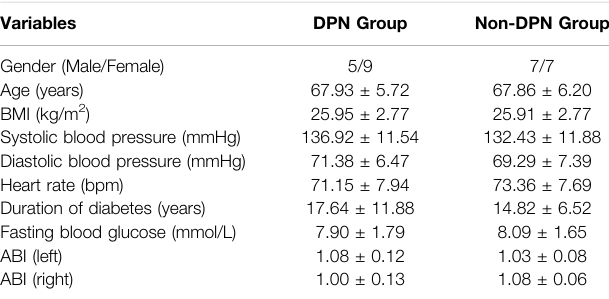
TABLE 1 | Demographic and physiological information of participants in DPN group and Non-DPN group (Mean ± SD). Variables DPN Group